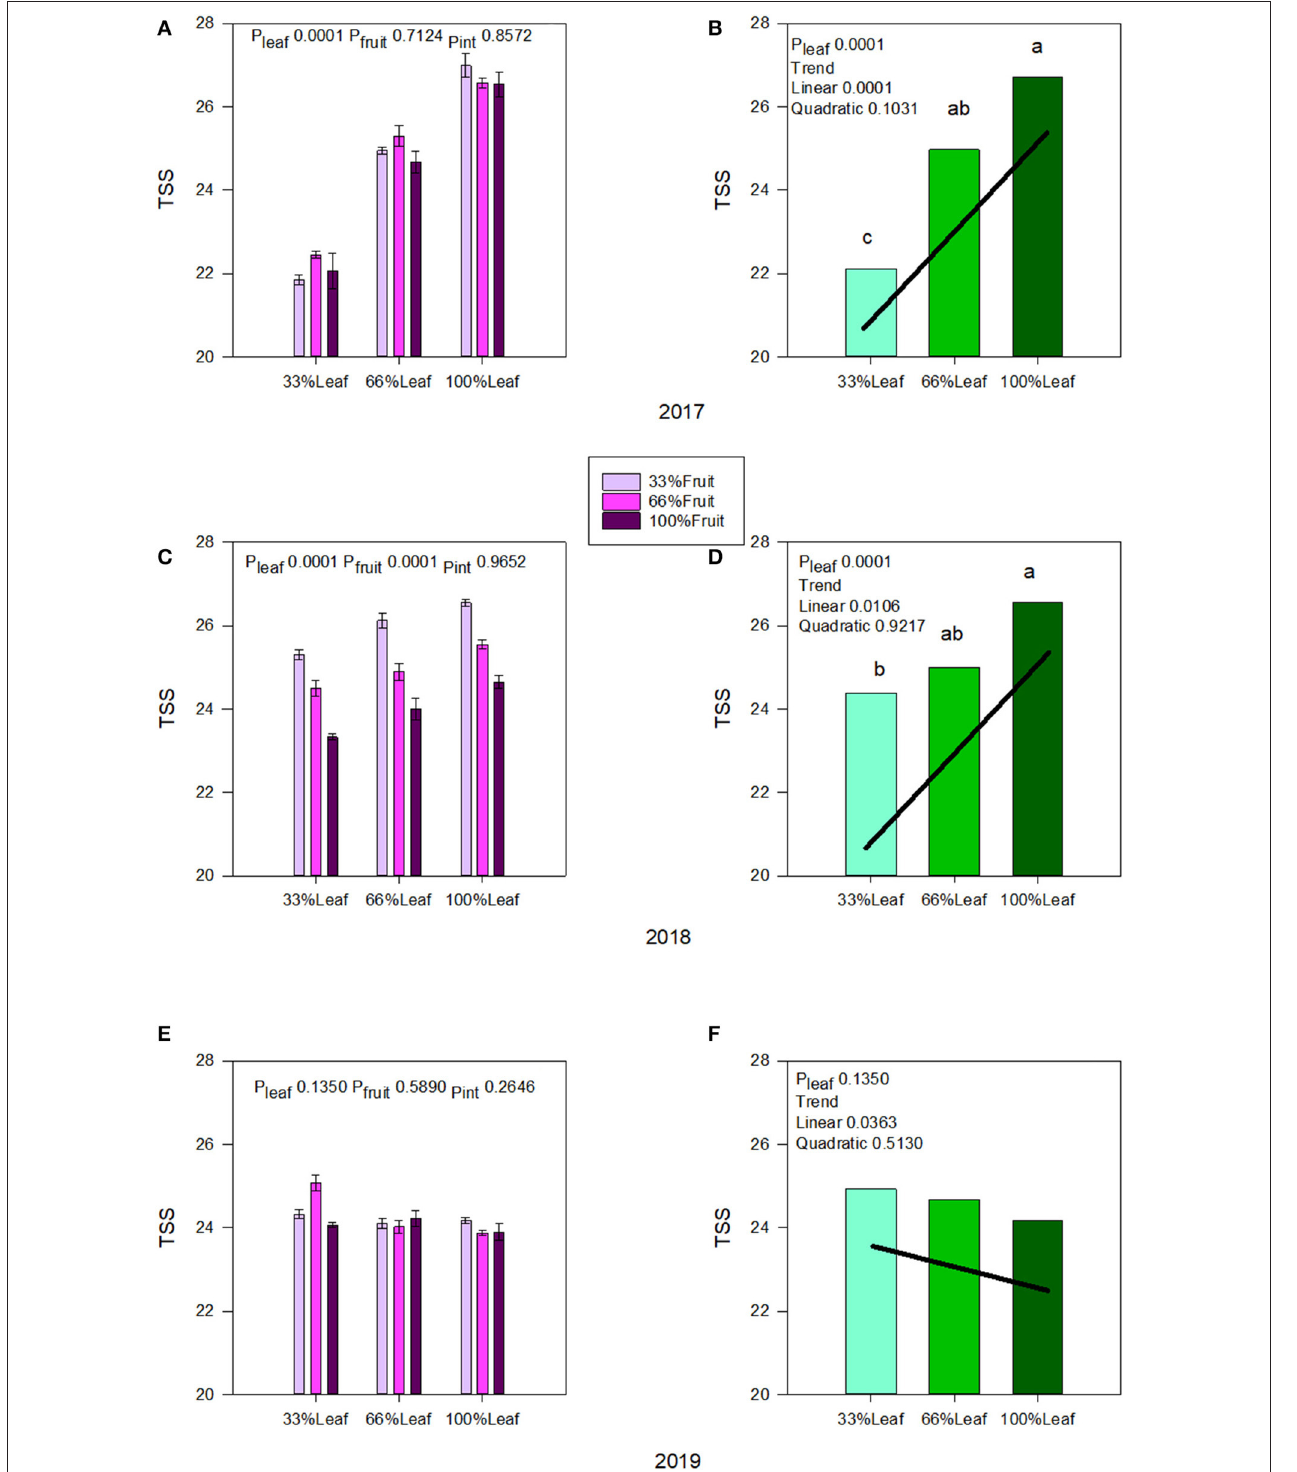
FIGURE 5 | Effect of defoliation and fruit removal on berry total soluble solids of Cabernet Sauvignon in 2017 (A,B) ; 2018 (C,D) ; and 2019 (E,F) . The interactive effects and simple means with standard error of the mean in each year are presented in (A,C,E) . The main effects of defoliation with significant trend lines are presented in (B,D,F) . Columns with different letters in main effect panels are significantly different at P < 0.05 according to Tukey’s HSD.